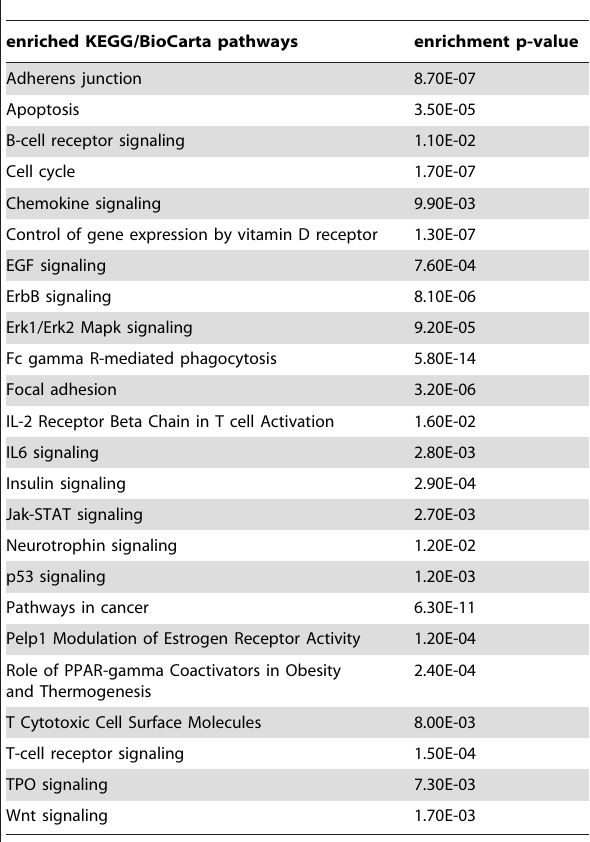
Table 3. NIMMI prioritized Crohn’s Disease enriched KEGG/ BioCarta